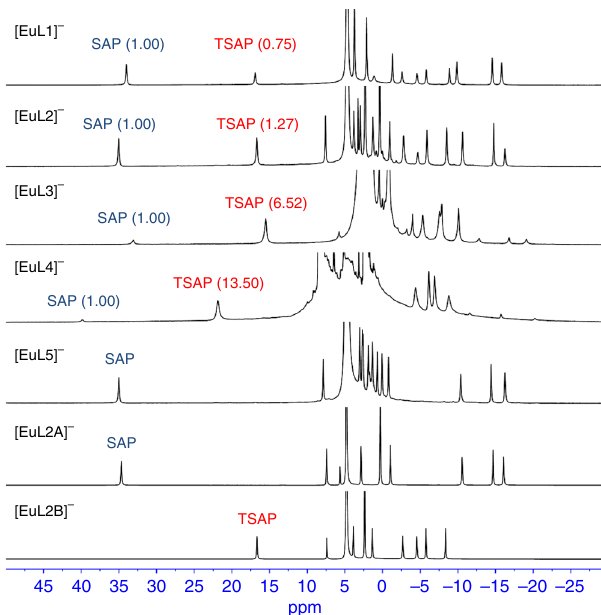
Fig. 3 1 H NMR spectra of Eu complexes. 1 H NMR spectra of [EuL1] − to [EuL5] − with isolated SAP isomer [EuL2A] − and TSAP isomer [EuL2B] − of [EuL2] − as isomer identi fi cation reference. The spectra gave ligand- dependent TSAP/SAP isomer ratios when Eu(III) is complexed with different ligands; attributed to the different substituents on the macrocyclic ring. The integrations of both isomer peaks are listed in parentheses with the integration of SAP isomer set as